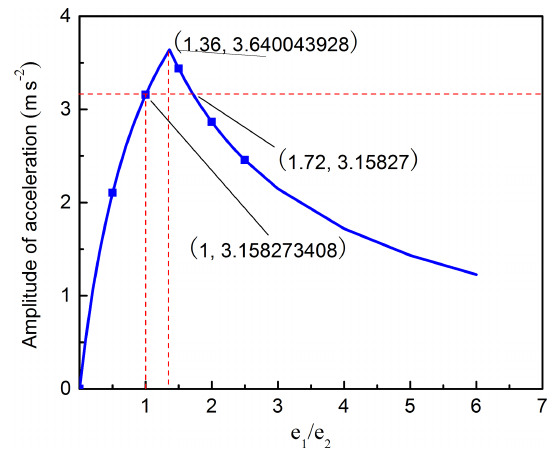
Figure 12. Effects of e 1 /e 2 on the amplitude when ω 1 (cid:54)= ω 2 and